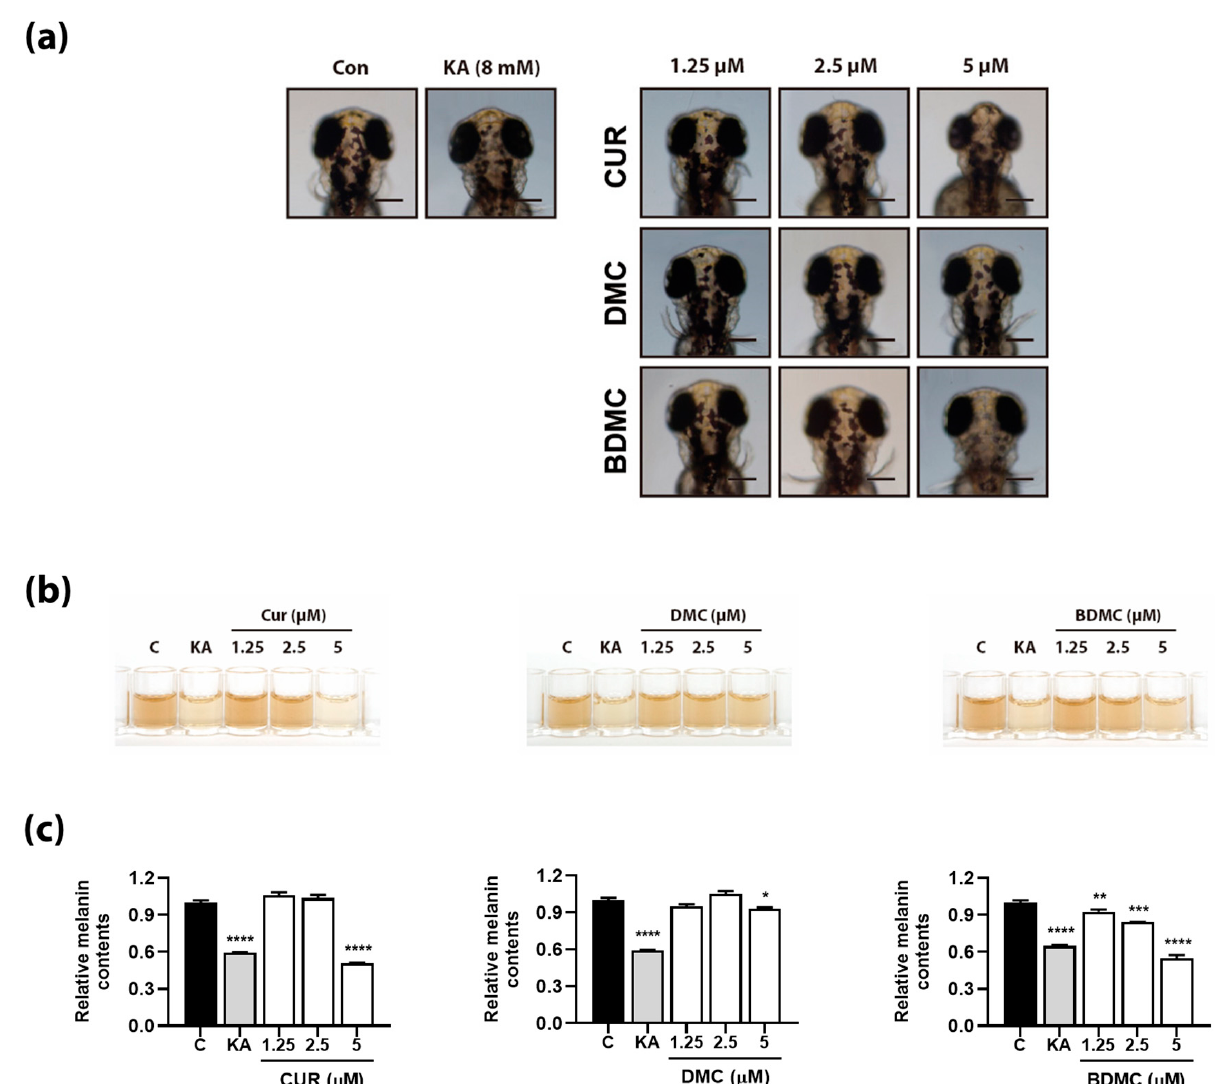
Figure 5. Effect of curcumin (CUR), dimethoxycurcumin (DMC), and bisdemethoxycurcumin (BDMC) on melanin production in zebrafish embryos. ( a ) Images of overhead view of zebrafish embryo at 72 h after exposure of various concentrations of CUR, DMC, and BDMC. ( b ) Color of whole-body lysate with 1 M NaOH. ( c ) Determined absorbance at 490 nm for melanin contents. Data are presented as mean ± standard deviation (SD) of triplicates. Significant differences are expressed by the symbols *, **, ***, and **** as * p < 0.05, ** p < 0.01, *** p < 0.001, and **** p < 0.0001, respectively.